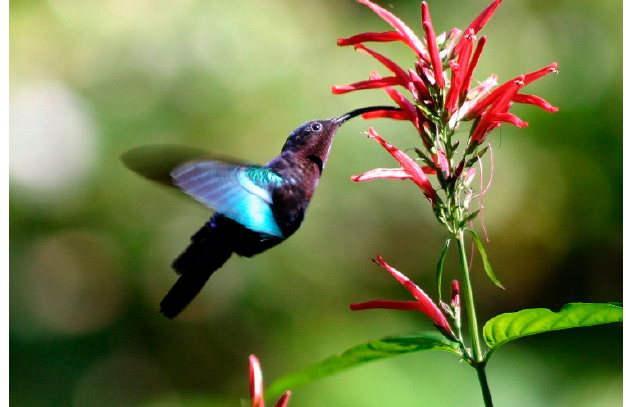
Figure 4. A hummingbird is capable of achieving a lift equal to its weight and an activity angle θ of 90° at lift-off and hovering [8].